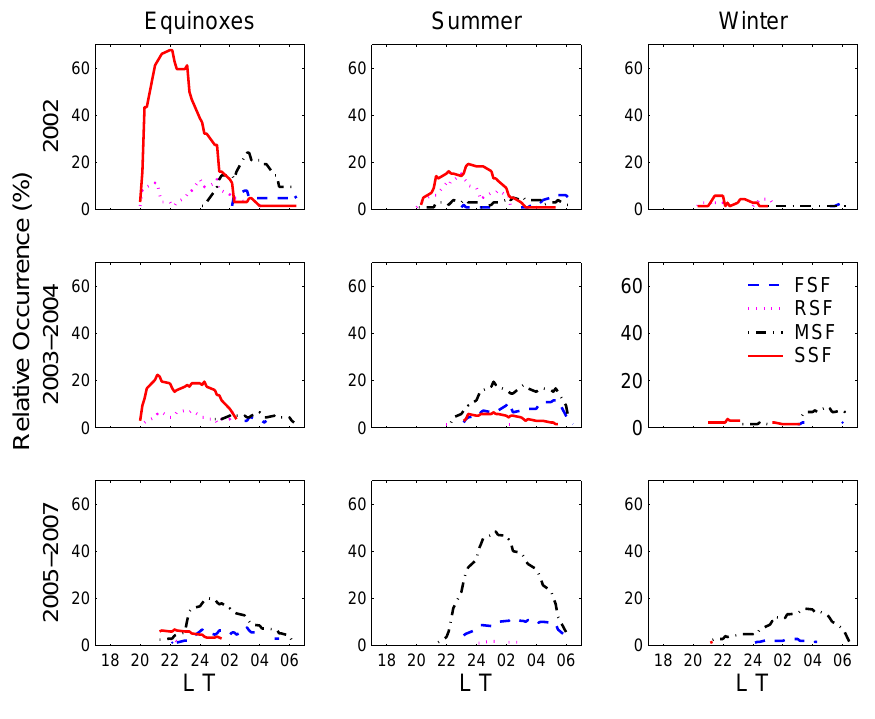
Fig. 3. The nighttime relative occurrence of each type SF observed at Hainan station in the different seasons during the magnetically quiet conditions from high solar activity year (2002) to low solar activity year (2005–2007). The 2003–2004 is the middle solar activity